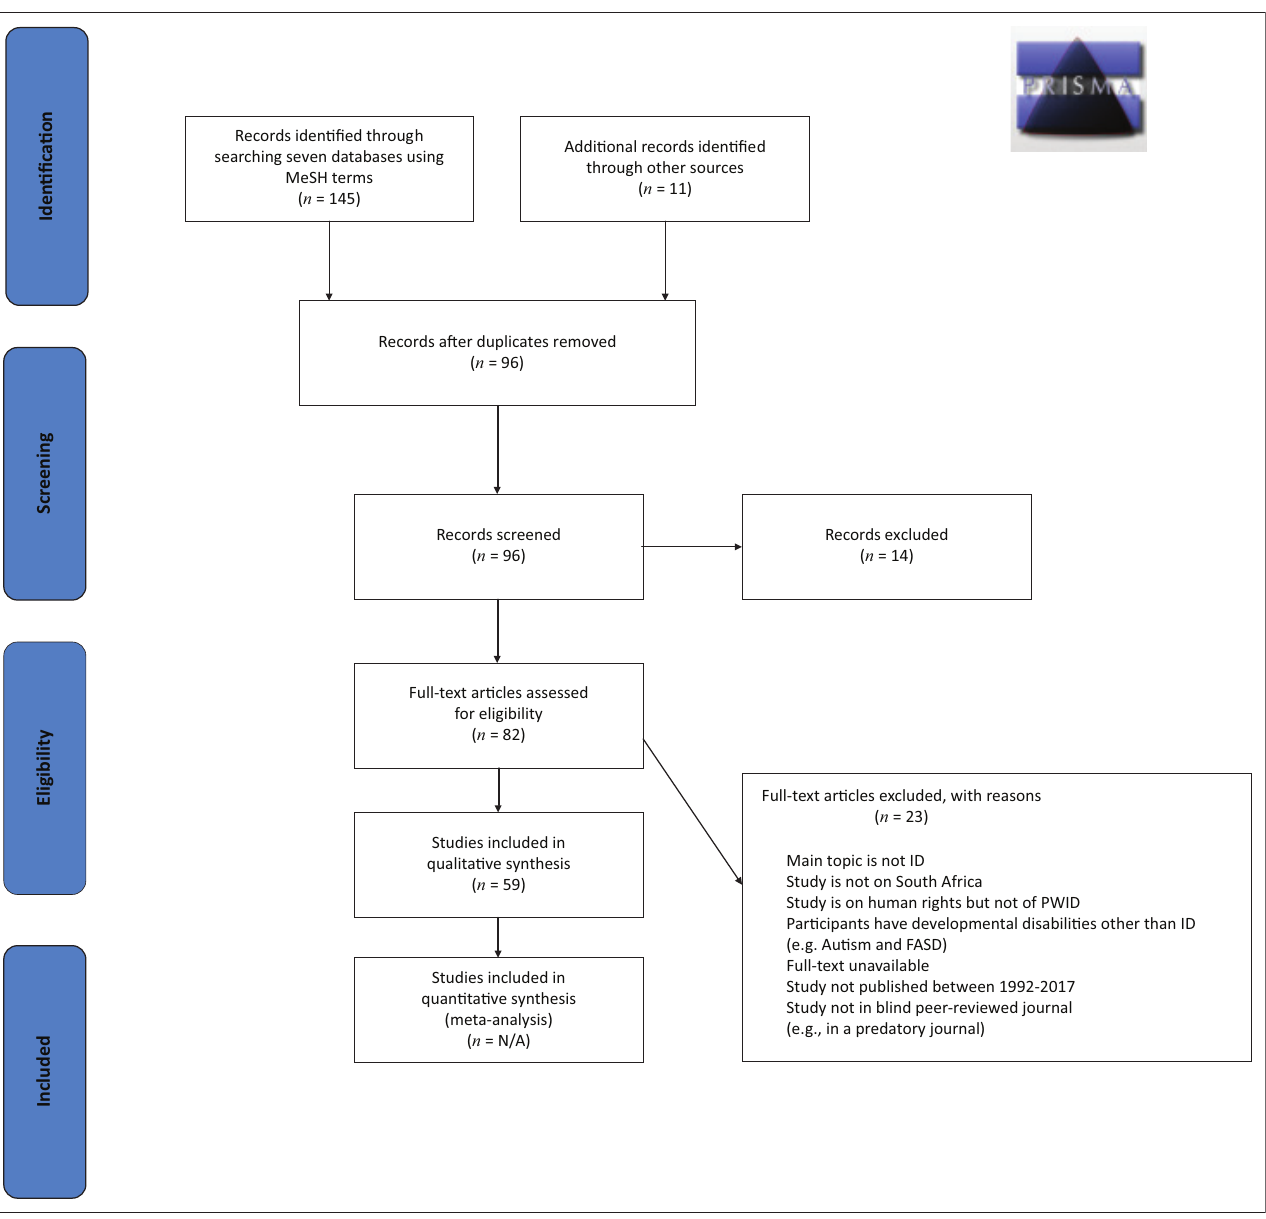
FIGURE 2: Preferred reporting items for systematic review and meta-analysis flow diagram – Results of study